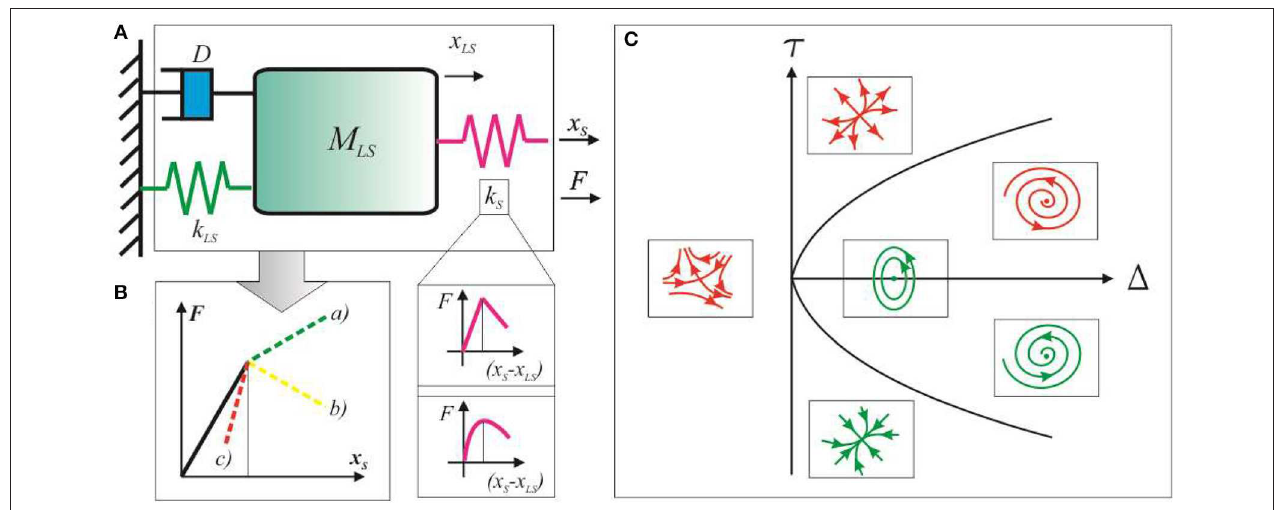
FIGURE 1 | (A) Lumped parameters model of a typical tensile testing device, where the sample can be modeled like a spring whose characteristic shows a softening branch; (B) Global behavior of the system consisting of both the load sensor and the sample, showing the relationship between the force ( F ) corresponding to the applied displacement ( x S ). When the sample enters the softening regime, F may increase (line a) or decrease (either line b or c) with x S , depending on the magnitude of the slope of the sample characteristic, ∂ F/ ∂ (x S -x LS ) , compared to the load sensor stiffness, k LS . In particular, line (b) corresponds to ∂ F/ ∂ (x S -x LS ) < 0 and k LS > | ∂ F/ ∂ (x S -x LS ) |, whereas c) to ∂ F/ ∂ (x S -x LS ) < 0 and k LS < | ∂ F/ ∂ (x S -x LS ) |. In order to evaluate the stability of the equilibrium position of the load sensor, its dynamic behavior can be linearized and modeled around such position through a Jacobian matrix. (C) The sign of the trace, τ , and the determinant, 1 , of the Jacobian matrix determine the stability of the equilibrium